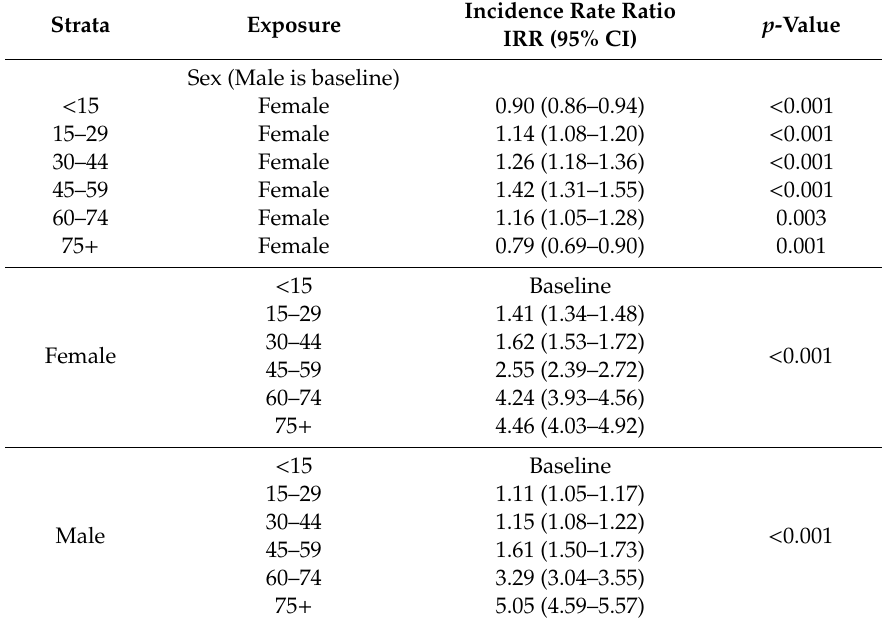
Table 3. Stratum specific Incidence Rate Ratios (IRR) for age and